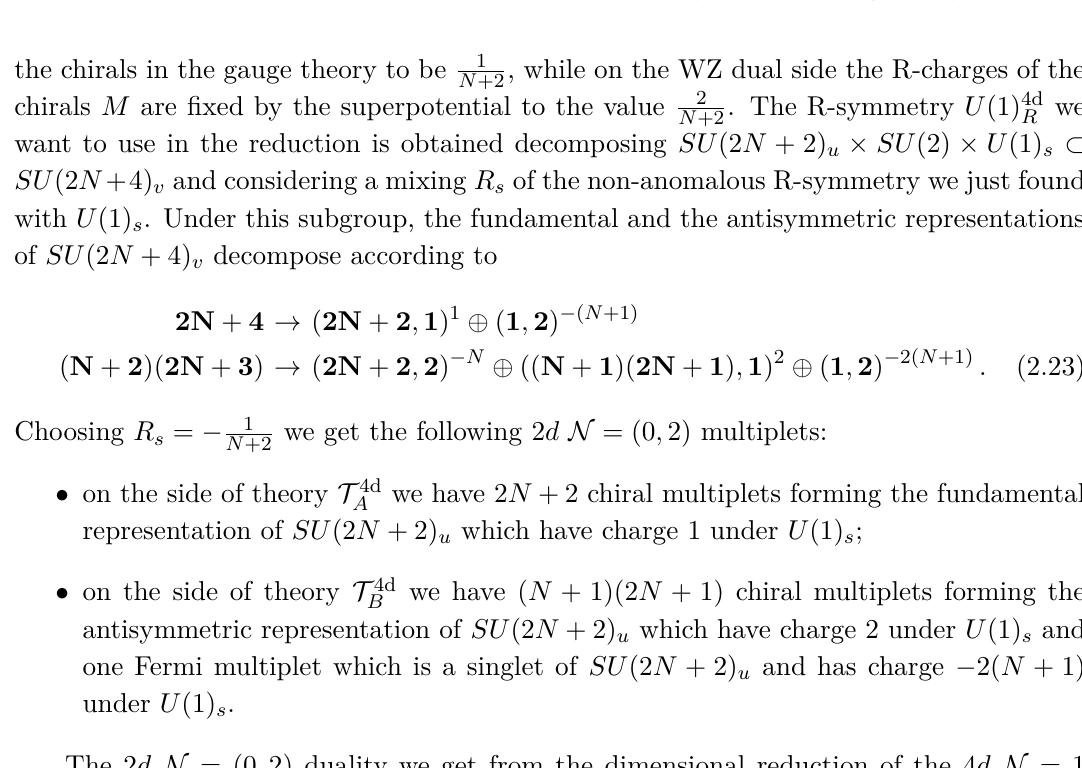
Table 2 . Transformation rules of the matter fields of theory T A under the global